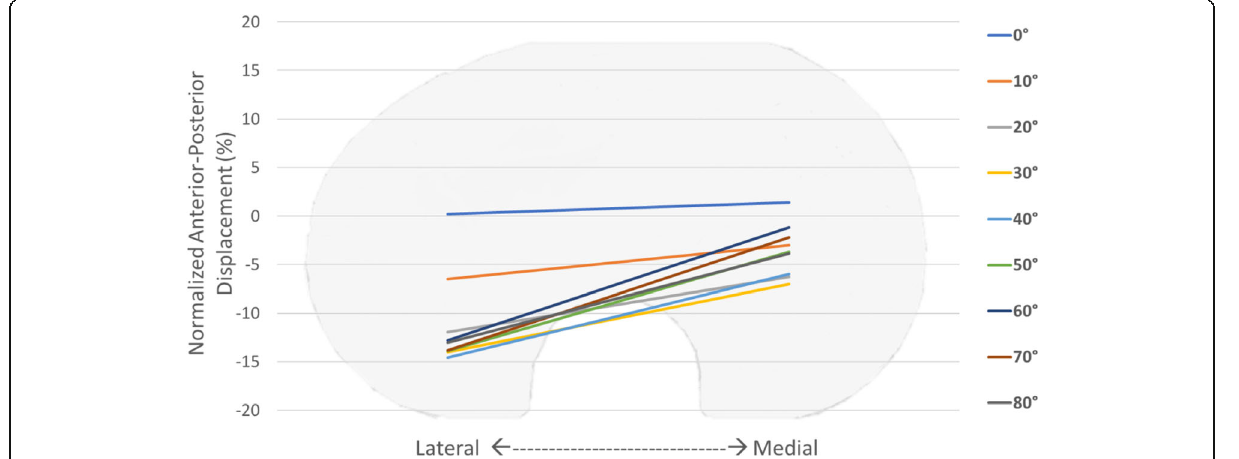
Fig. 6 Normalized Anterior-Posterior translation of the femoral